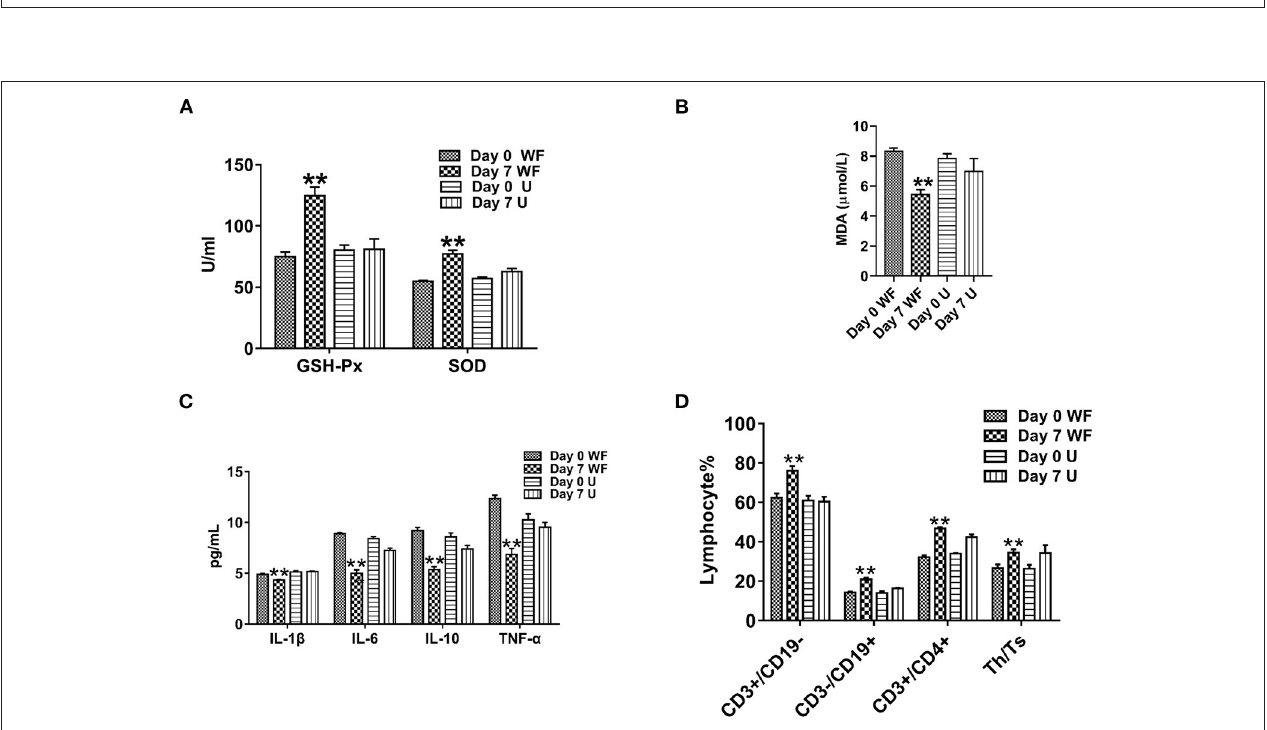
FIGURE 2 | Effects of the waterfall forest environment (WF) on antioxidant indexes and immunity. (A) Glutathione peroxidase (GSH-Px) and superoxide dismutase (SOD) activity. (B) Malondialdehyde (MDA) content. (C) Effects of the WF on the expression of inflammatory factors. (D) Effects of the WF on immune levels. ** p < 0.01, Day 7 WF vs. Day